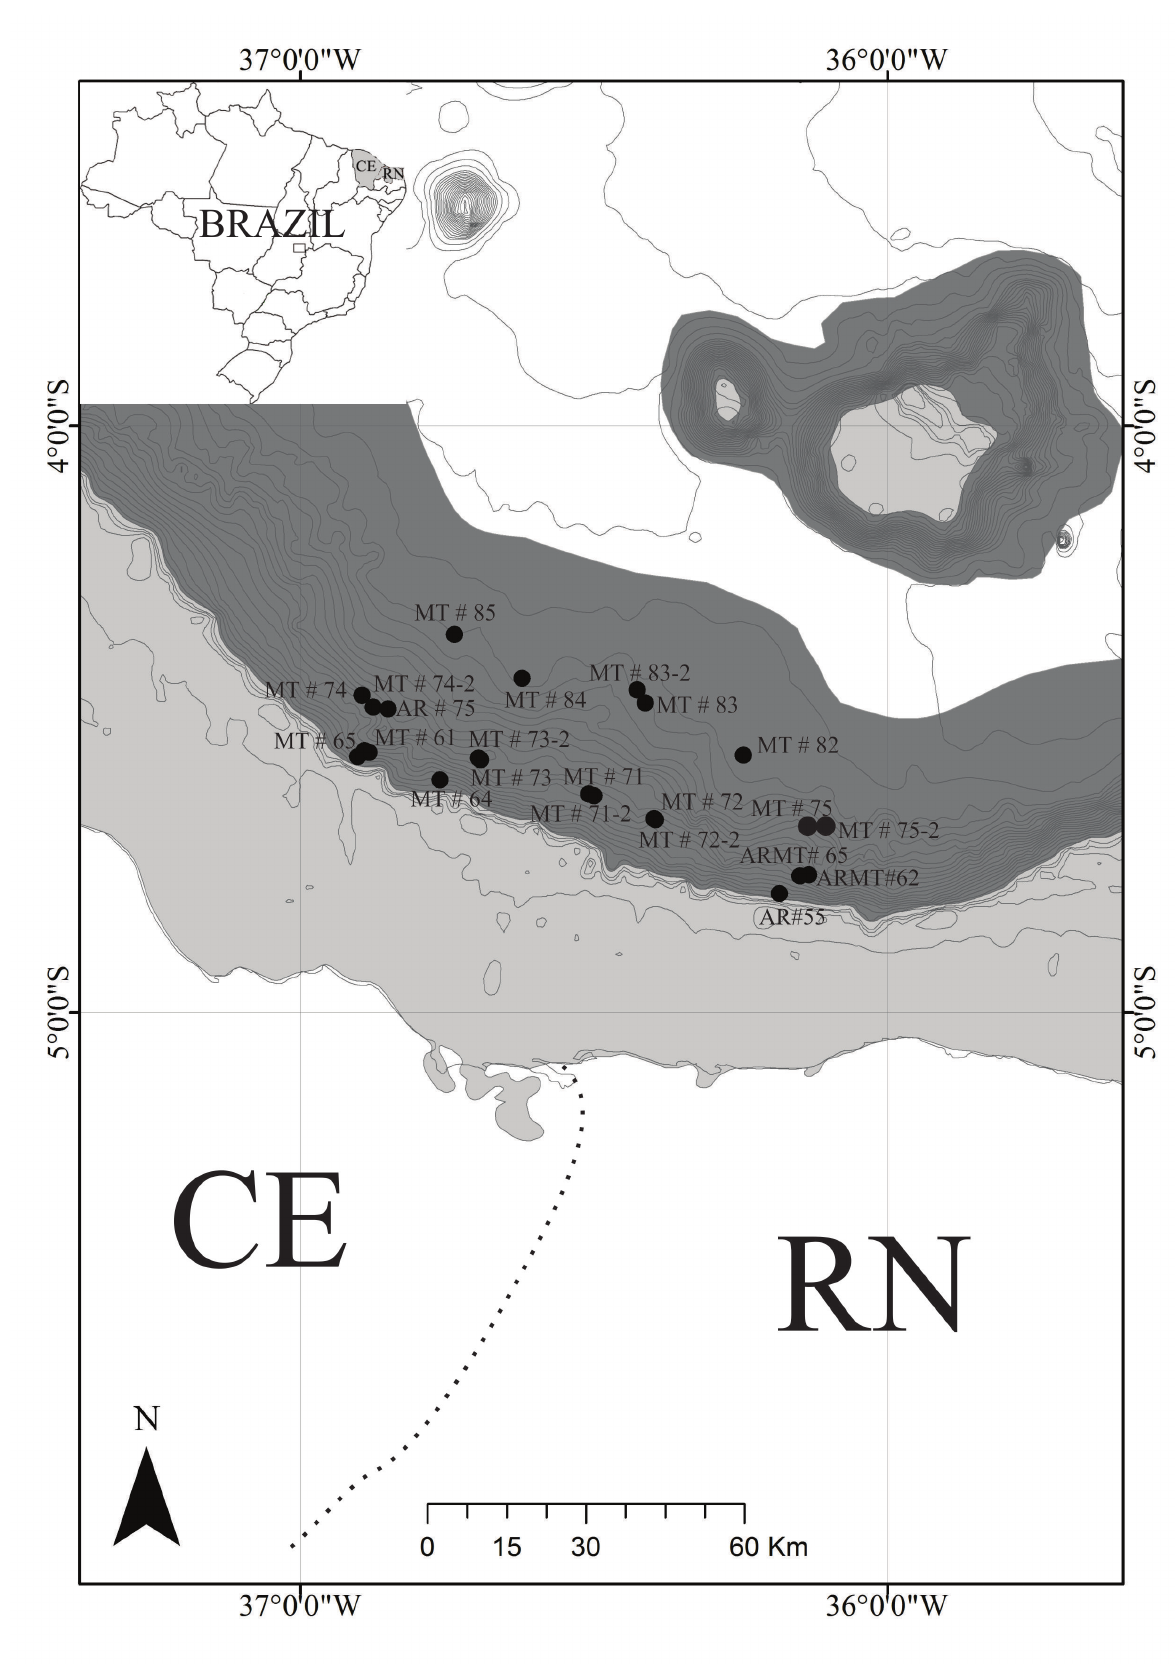
Figure 1. Location of the sampling stations between the states of Rio Grande do Norte and Ceará, northeast of